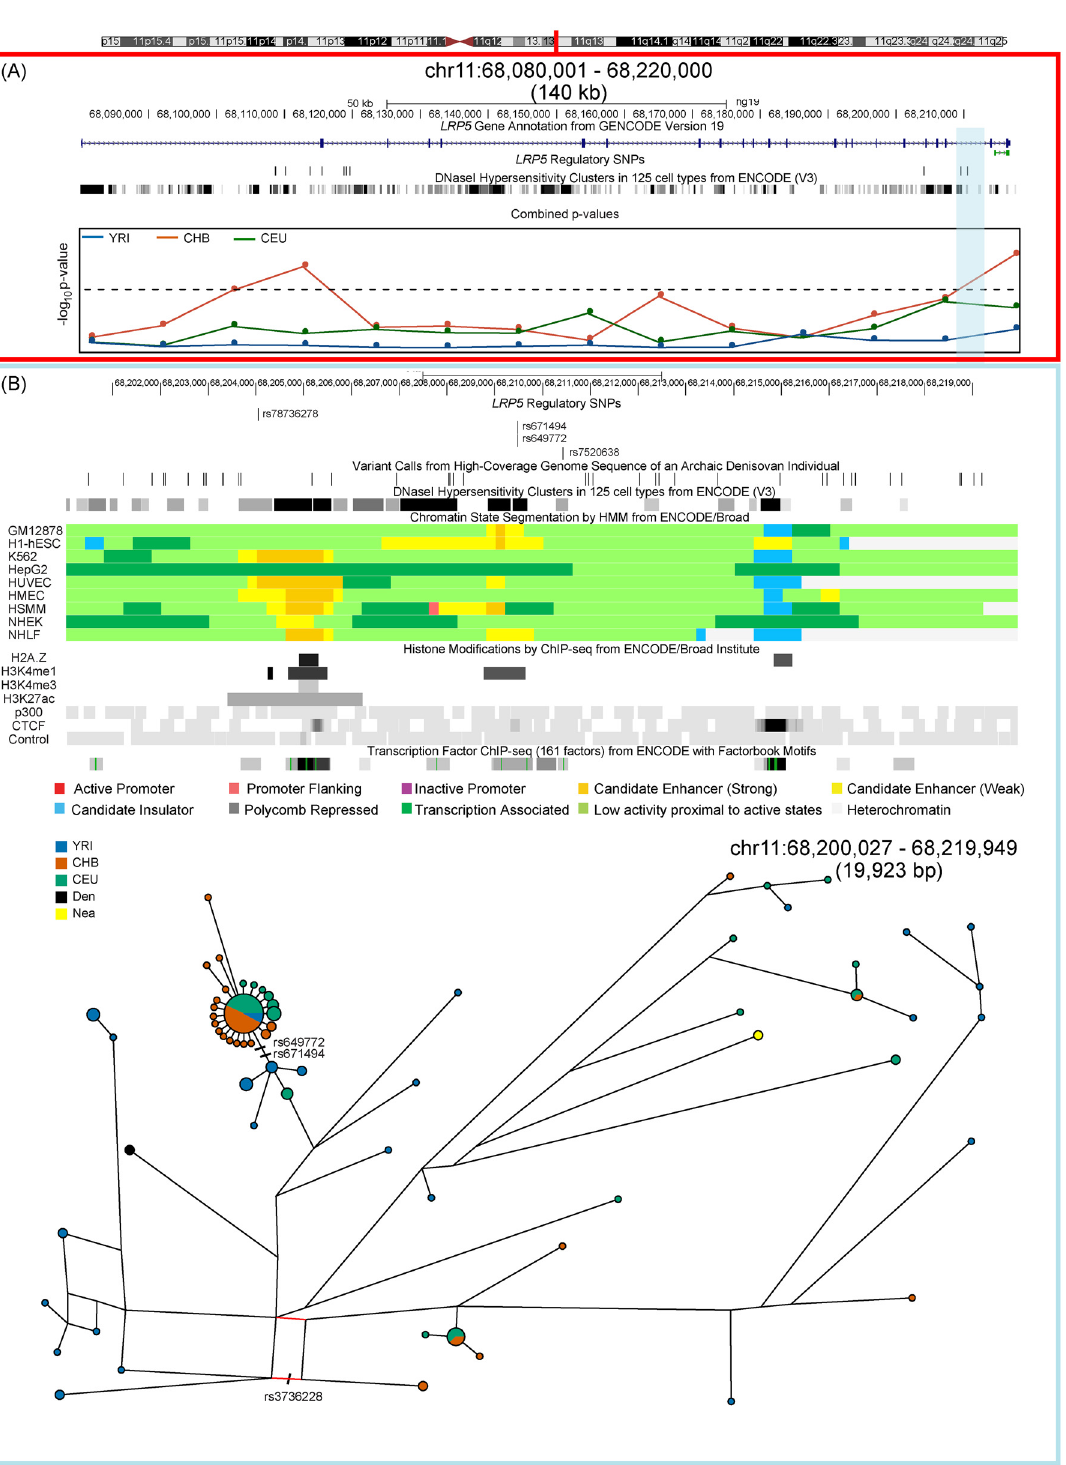
Fig 4. Positive selection at the LRP5 locus. (A). A 140 kb region on chromosome 6 that spans LRP5 showing GENCODE (Version 19) transcript annotation. Positions of 11 candidate regulatory variants and DNase I Hypersensitivity Clusters are shown along with the − log 10 of the combined p-values from frequency-spectrum-based analysis in three continental populations. The significance threshold is indicated by the dashed line and two non-overlapping 10 kb windows have a significant combined p-value in CHB. (B). A closer look at the 3 ’ selected region in East Asians (highlighted in blue). The region contains both variants with the highest derived allele frequency in East Asians ( rs649772 and rs671494 ) that lie in a DNase I hypersensitivity cluster